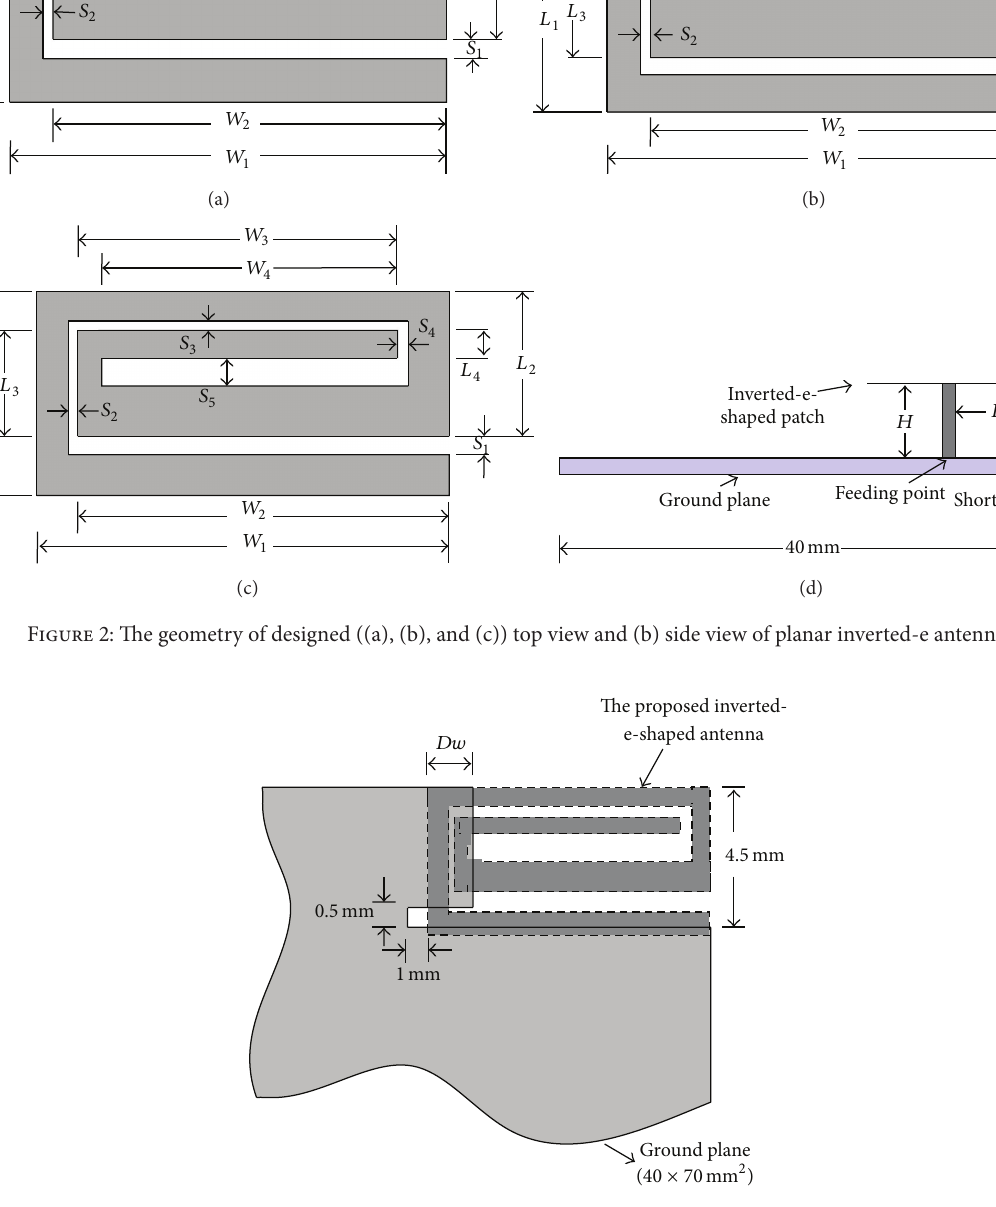
Figure 3: The geometry of the designed top view of proposed